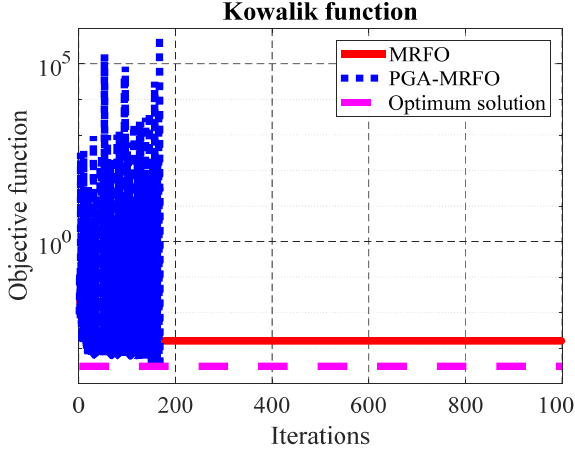
Figure 7. Converges curves for F 15 .